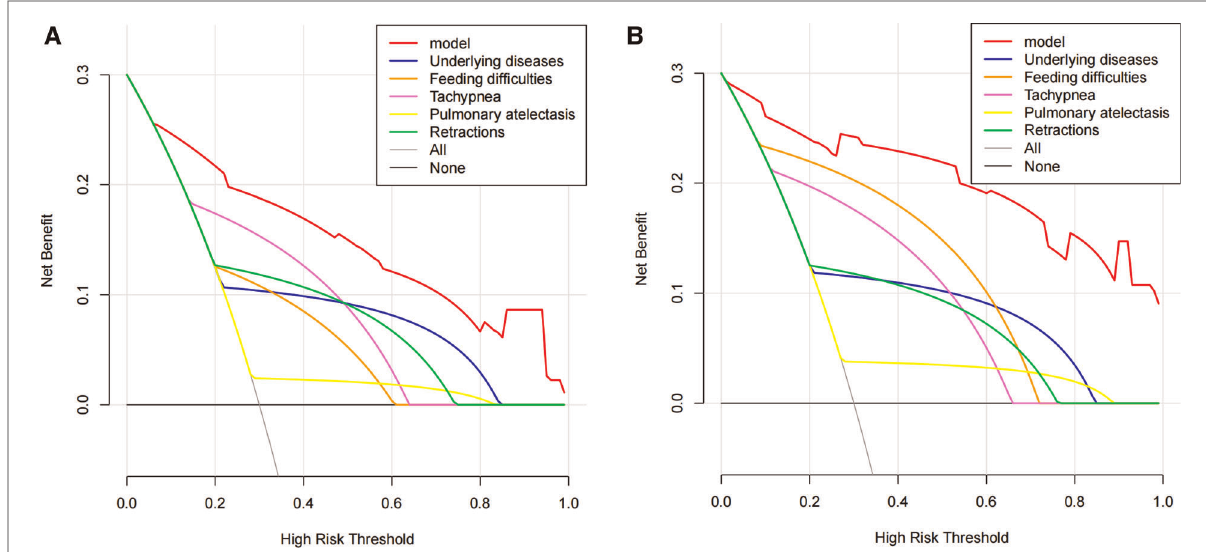
FIGURE 5 Decision curve analysis (DCA) of the apnea nomogram and single predictors. DCA was used to evaluate the clinical utility of the nomogram (17, 18). The y-axis indicates the net bene fi t. The red line represents the apnea nomogram. The grey line indicates the presumption that all patients had apnea. The black line indicates the presumption that no patients had apnea. The net bene fi t was estimated by subtracting the proportion of all patients with false positives from the true positive proportion, weighted by the relative harm of not obtaining treatment in comparison to the negative outcomes of an unnecessary treatment (14, 19). The decision curve indicated that if the threshold probability of a patient or doctor is 10% using the nomogram to predict the apnea in patients with bronchiolitis, it could add a greater advantage than the treat-all-patients scheme or the treat-none scheme. ( A ) Training cohort; ( B ) external validation